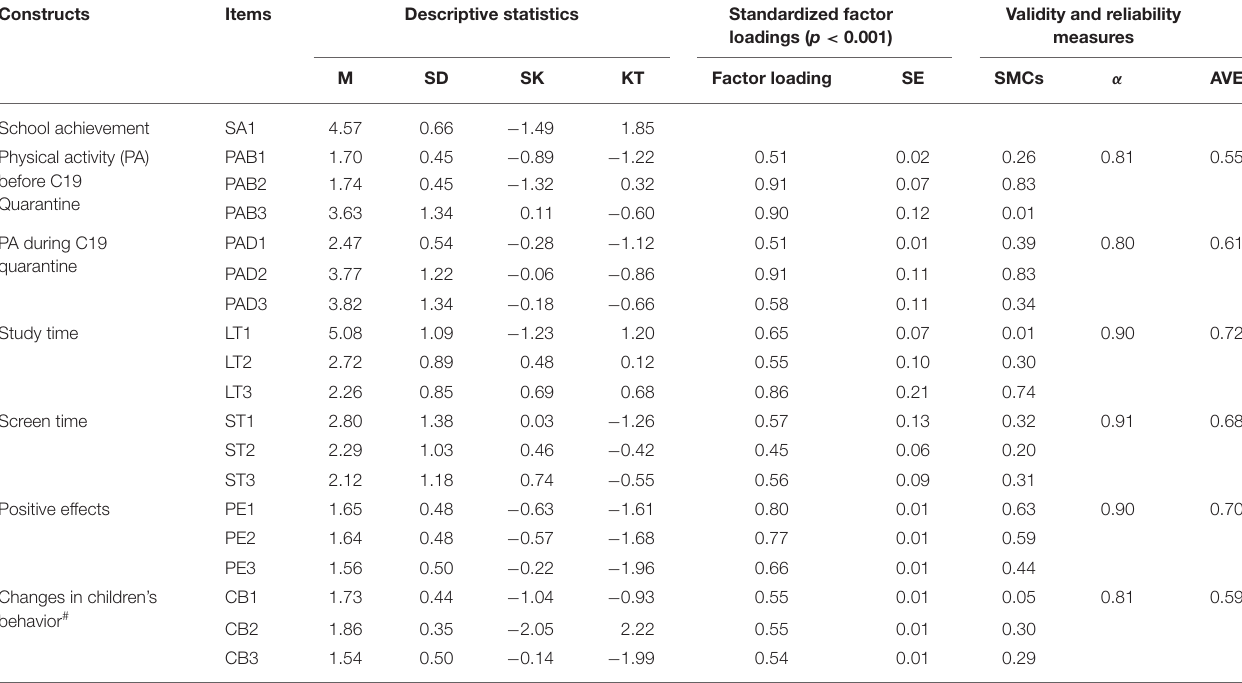
TABLE 2 | Descriptive statistics and CFA item statistics and validity and reliability indices of the measurement model. Constructs Items